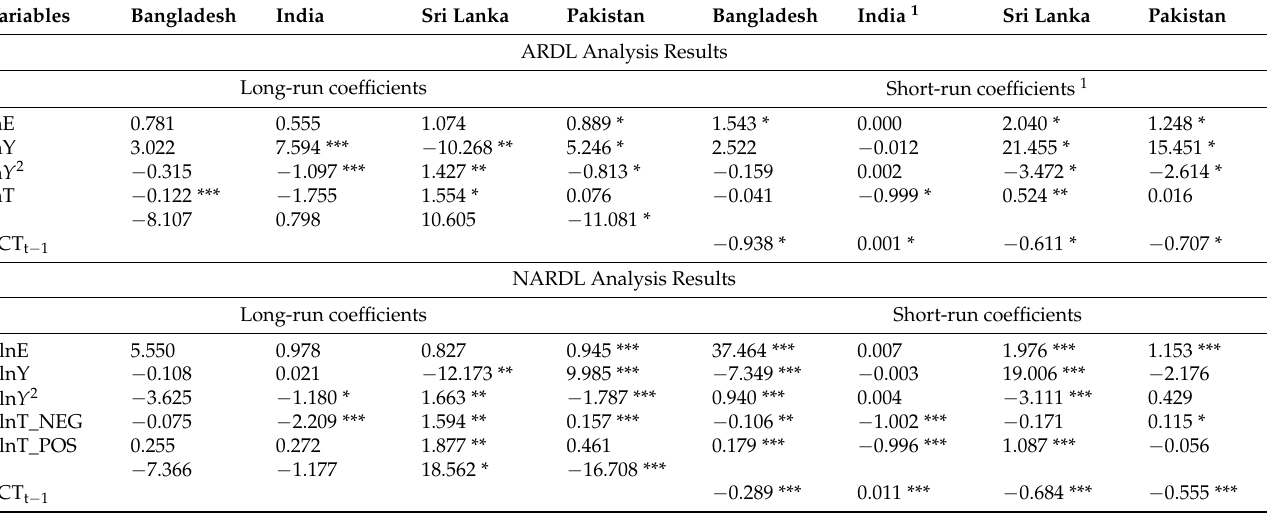
Table 5. Results of ARDL and NARDL